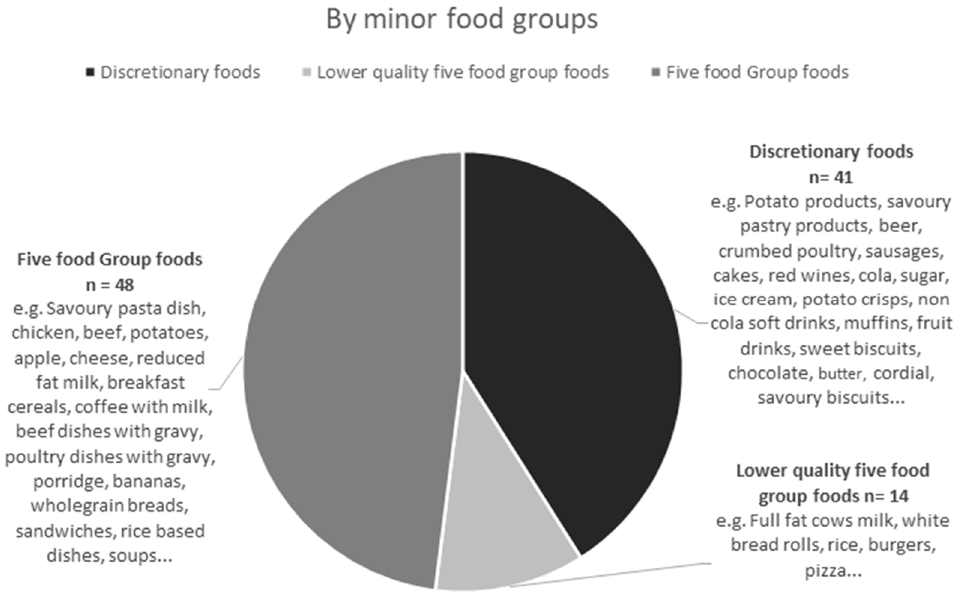
Figure 2. Number of the 100 most popular foods by frequency that were classified as five food group, lower quality five food group and discretionary foods, with a selection of the foods in each category listed.